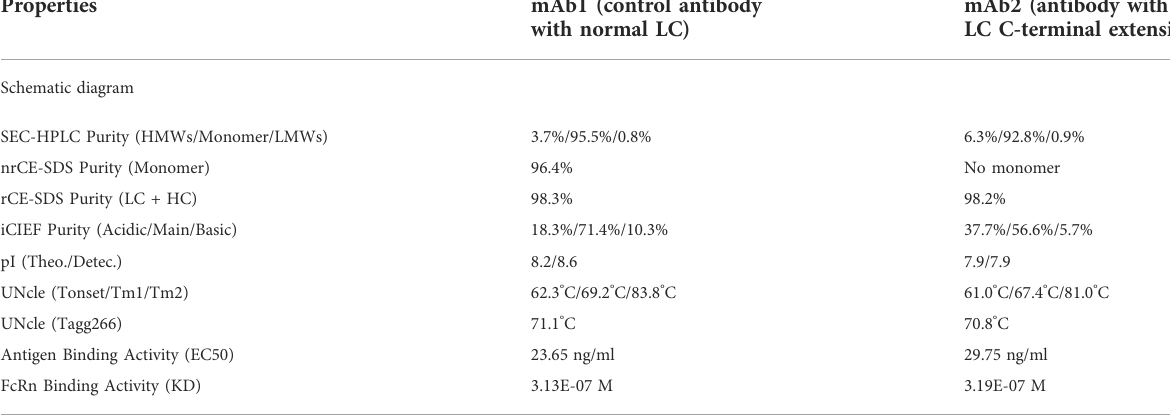
TABLE 1 Properties comparison of normal antibody and LC C-terminal extension variant.